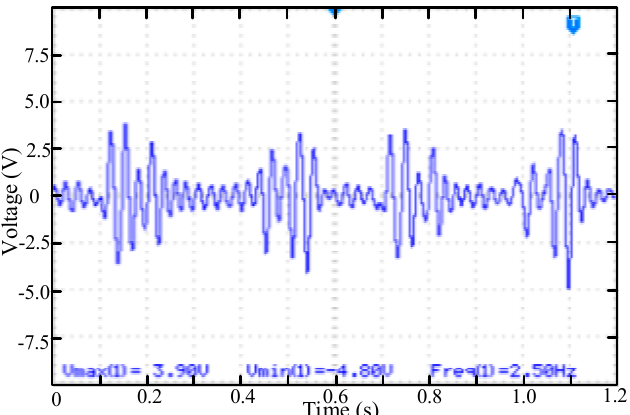
Figure 10. The voltage waveform of the piezoelectric beam while rotating mass block low amplitude reciprocating swing.